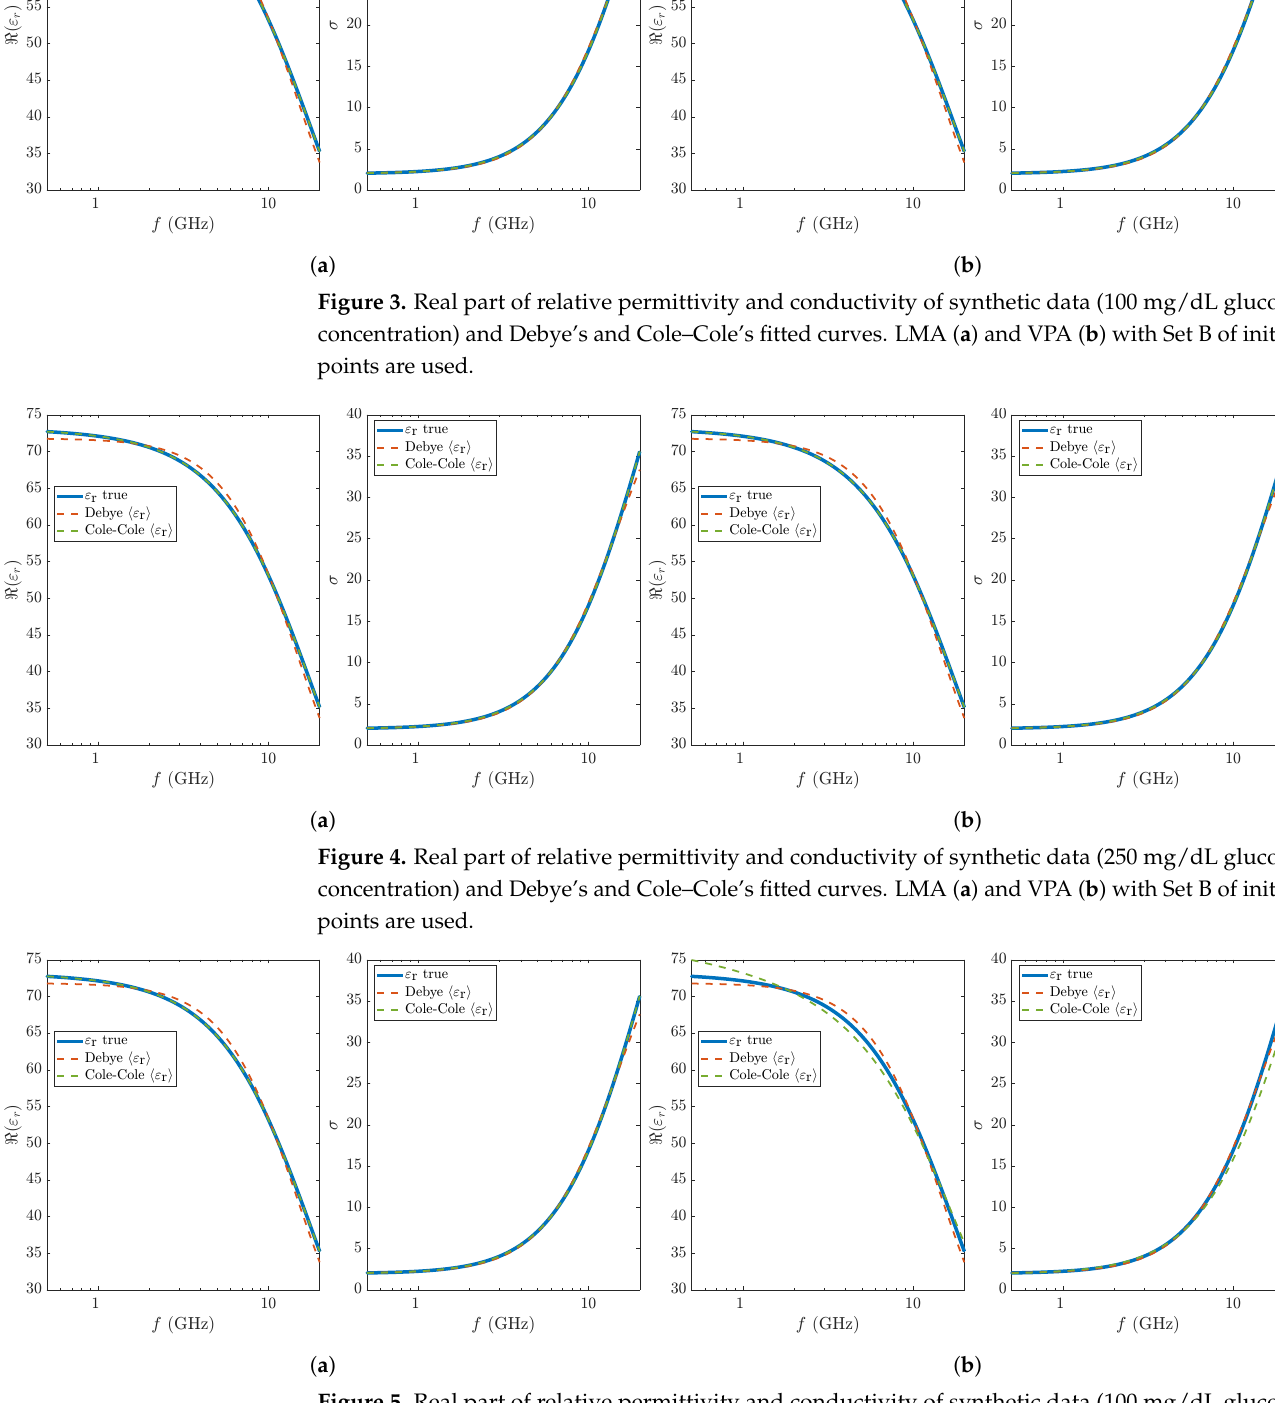
Figure 5. Real part of relative permittivity and conductivity of synthetic data (100 mg/dL glucose concentration) and Debye’s and Cole–Cole’s fitted curves. LMA ( a ) and VPA ( b ) with Set C of initial points are